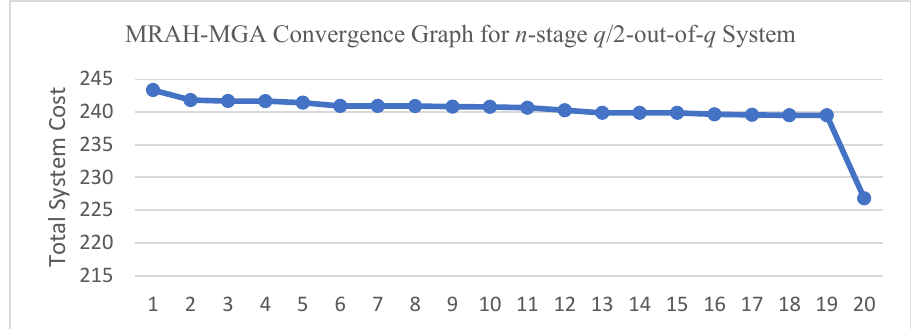
Figure 17. The convergence graph of the n -stage q /2-out-of- q system for the MRAH–MGA combined method.